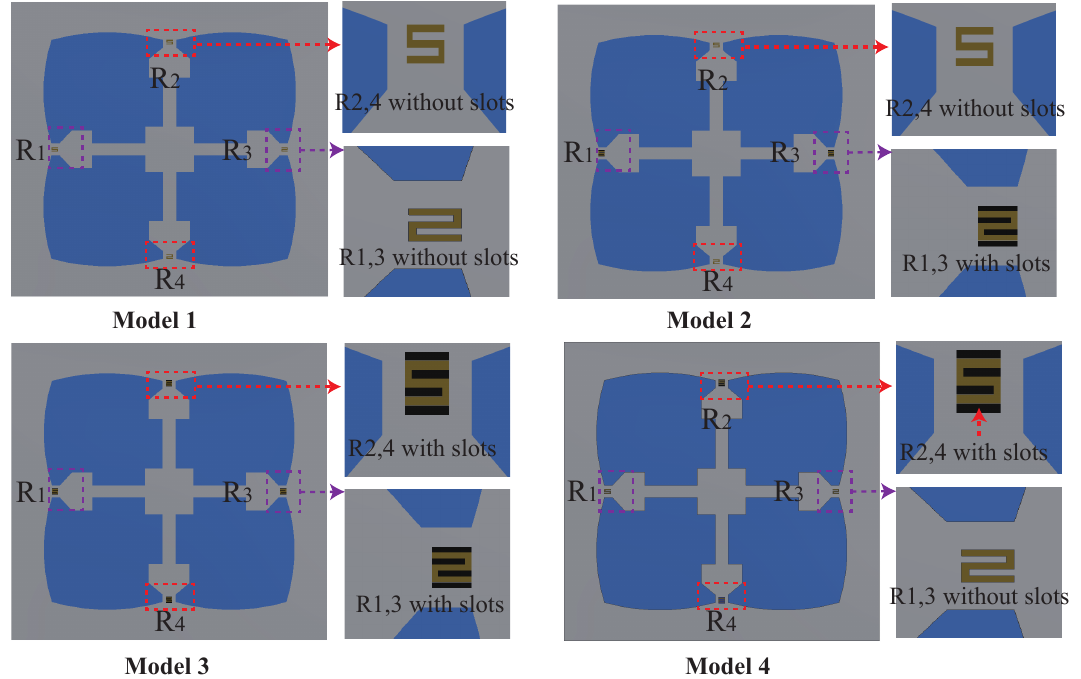
Figure 7. The designs of stress concentration regions (SCRs). Model 1: R 1,3 and R 2,4 without rectangular slots; Model 2: R 1,3 with rectangular slots and R 2,4 without rectangular slots; Model 3: R 1,3 and R 2,4 with rectangular slots; Model 4: R 1,3 without rectangular slots and R 2,4 with rectangular slots.